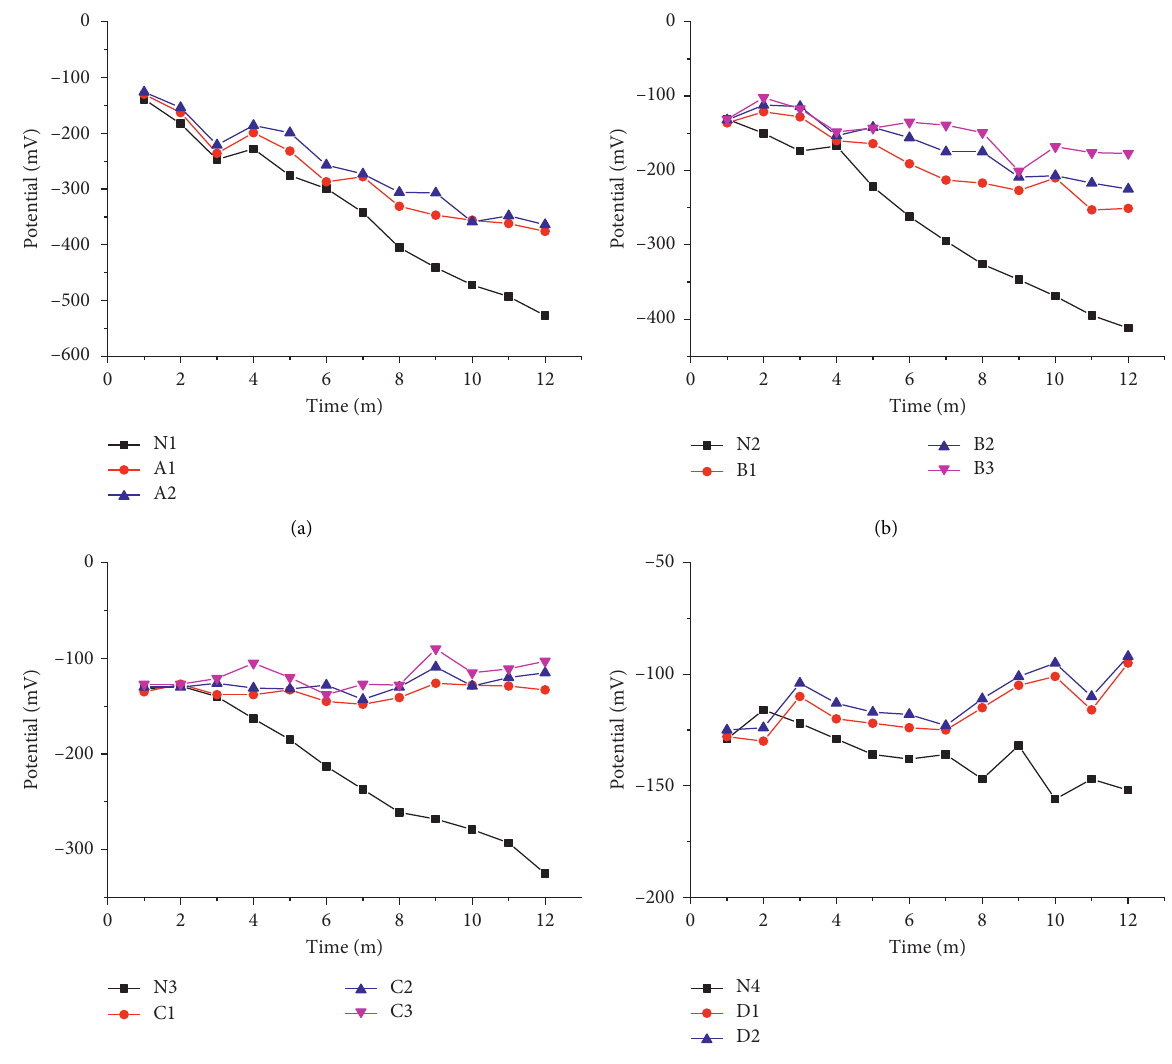
Figure 3: Composite corrosion